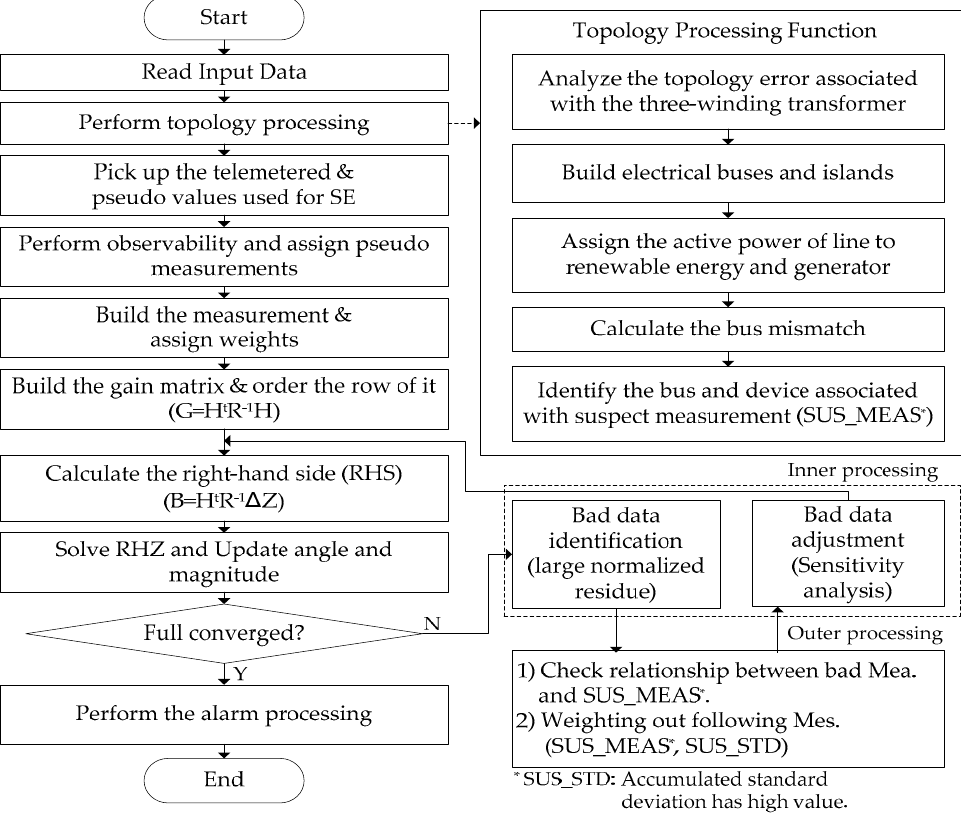
Figure 7. State estimation structure.